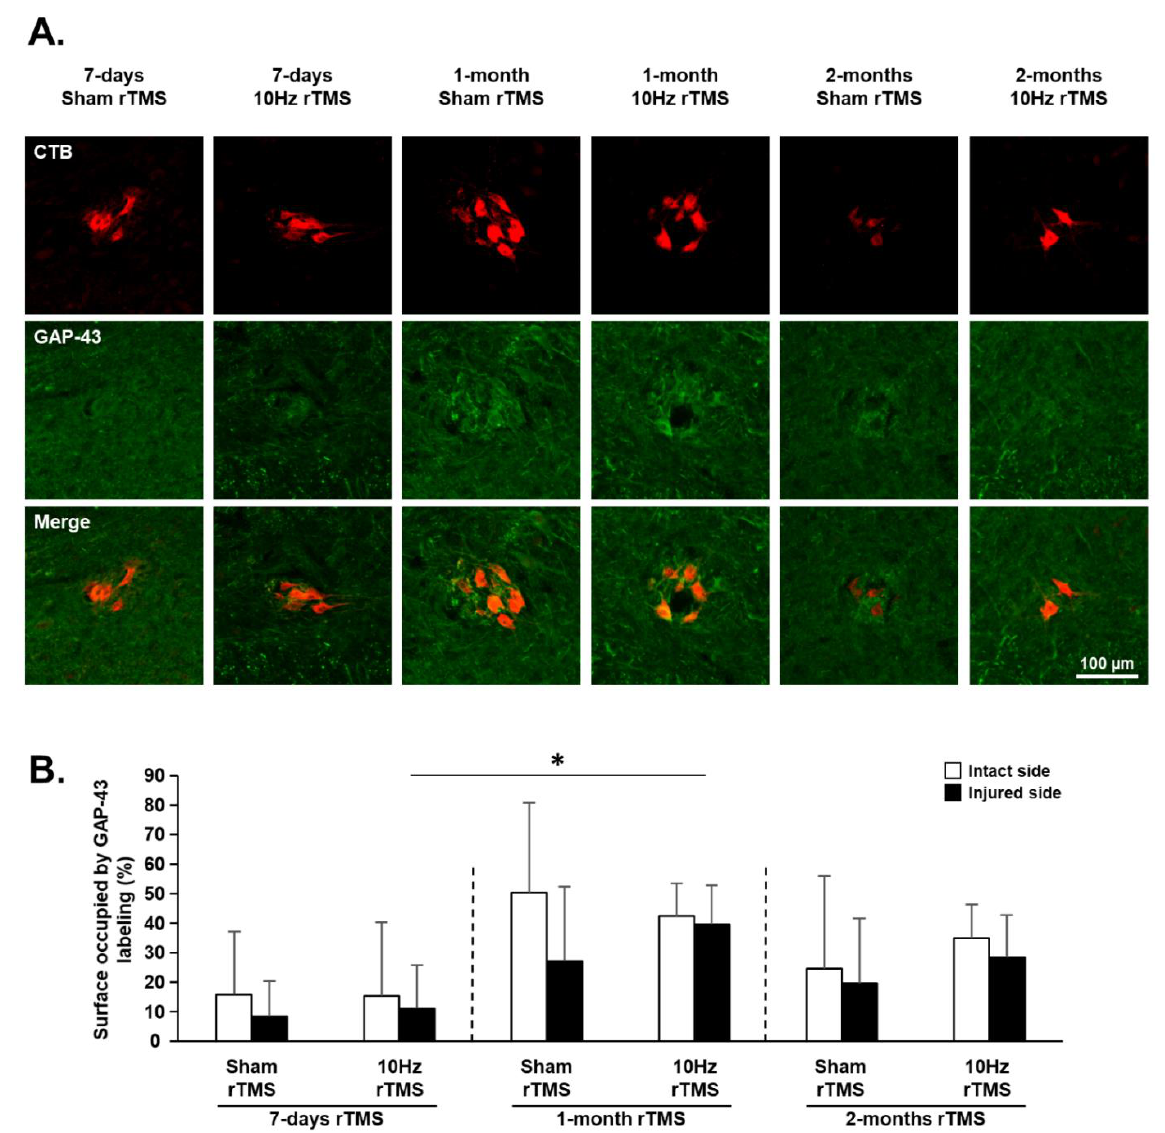
Figure 7. GAP-43 expression approximate to phrenic motoneurons following C2 hemisection: ( A ) representative images showing the surface occupied by GAP-43 labeling around denervated phrenic motoneurons labeled with CTB in C2 hemisected rats, following 7 days, 1 month, or 2 months of Sham or 10 Hz rTMS treatment; ( B ) quantification of the area occupied by GAP-43 labeling approximate to phrenic motoneurons on the intact and injured sides of Sham or 10 Hz rTMS-treated C2 hemisected animals following 7 days, 1 month, or 2 months of treatment. There is no difference between the intact and the injured sides for the different groups (paired t -test for intact vs. injured side, p > 0.05; * 7-day 10 Hz rTMS compared with 1-month 10 Hz rTMS for the injured side (Student’s t -test, p = 0.017).